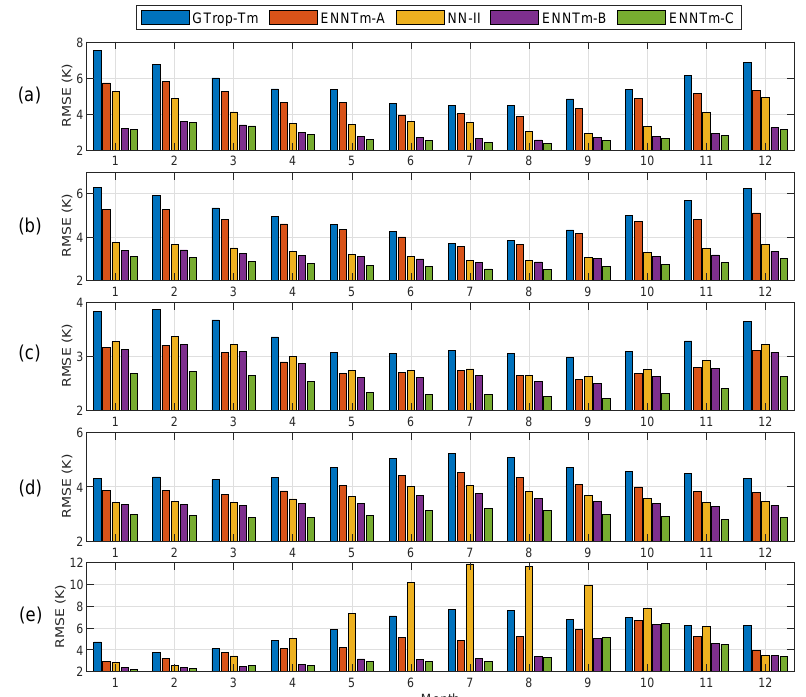
Figure 14. The statistics of RMSE for each model in different months in the ( a ) NFZ; ( b ) NTZ; ( c ) TZ; ( d ) STZ; and ( e )